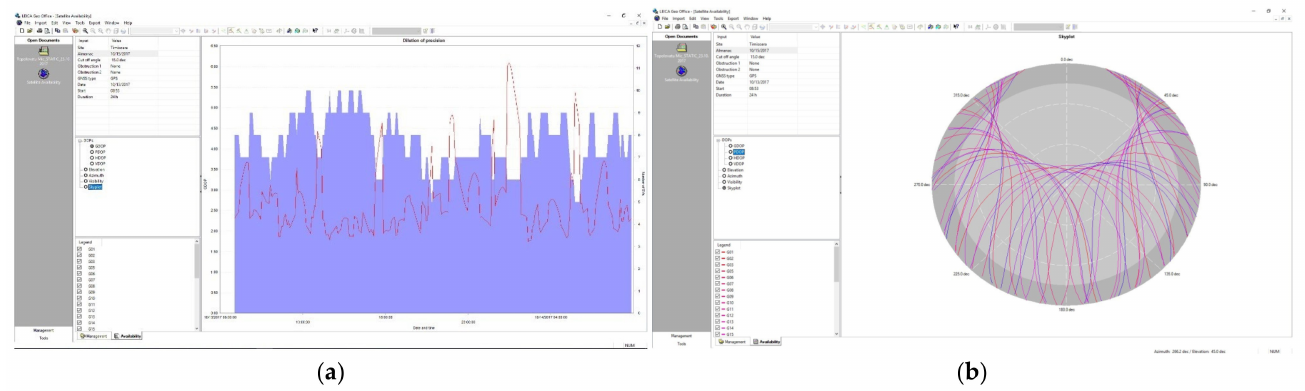
Figure 9. Planning measurements: ( a ) Chart of GDOP Values Topolov ă ¸tu Mic; ( b ) Constellation and trajectory of the satellites for Topolov ă ¸tu Mic.